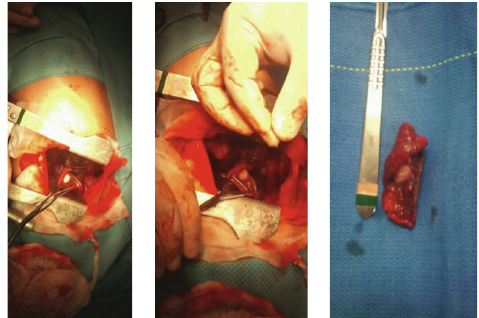
Figure 4: Nonanatomic pulmonary resection of superior and inferior left lobe was performed by posterolateral